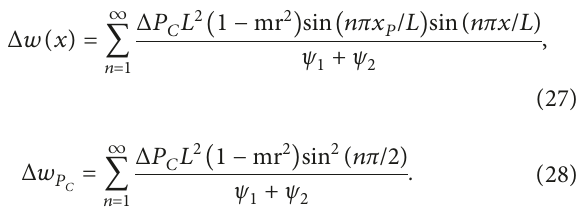
Figure 9: Analysis model in the transient